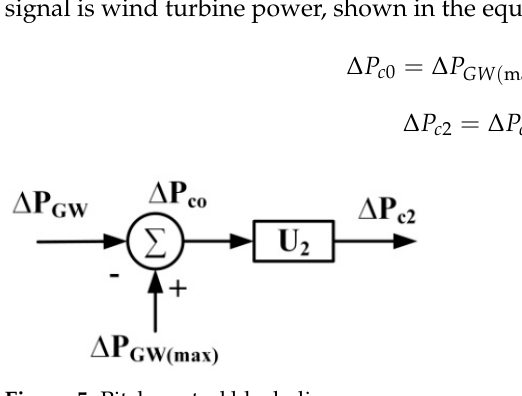
Figure 5. Pitch control block diagram.